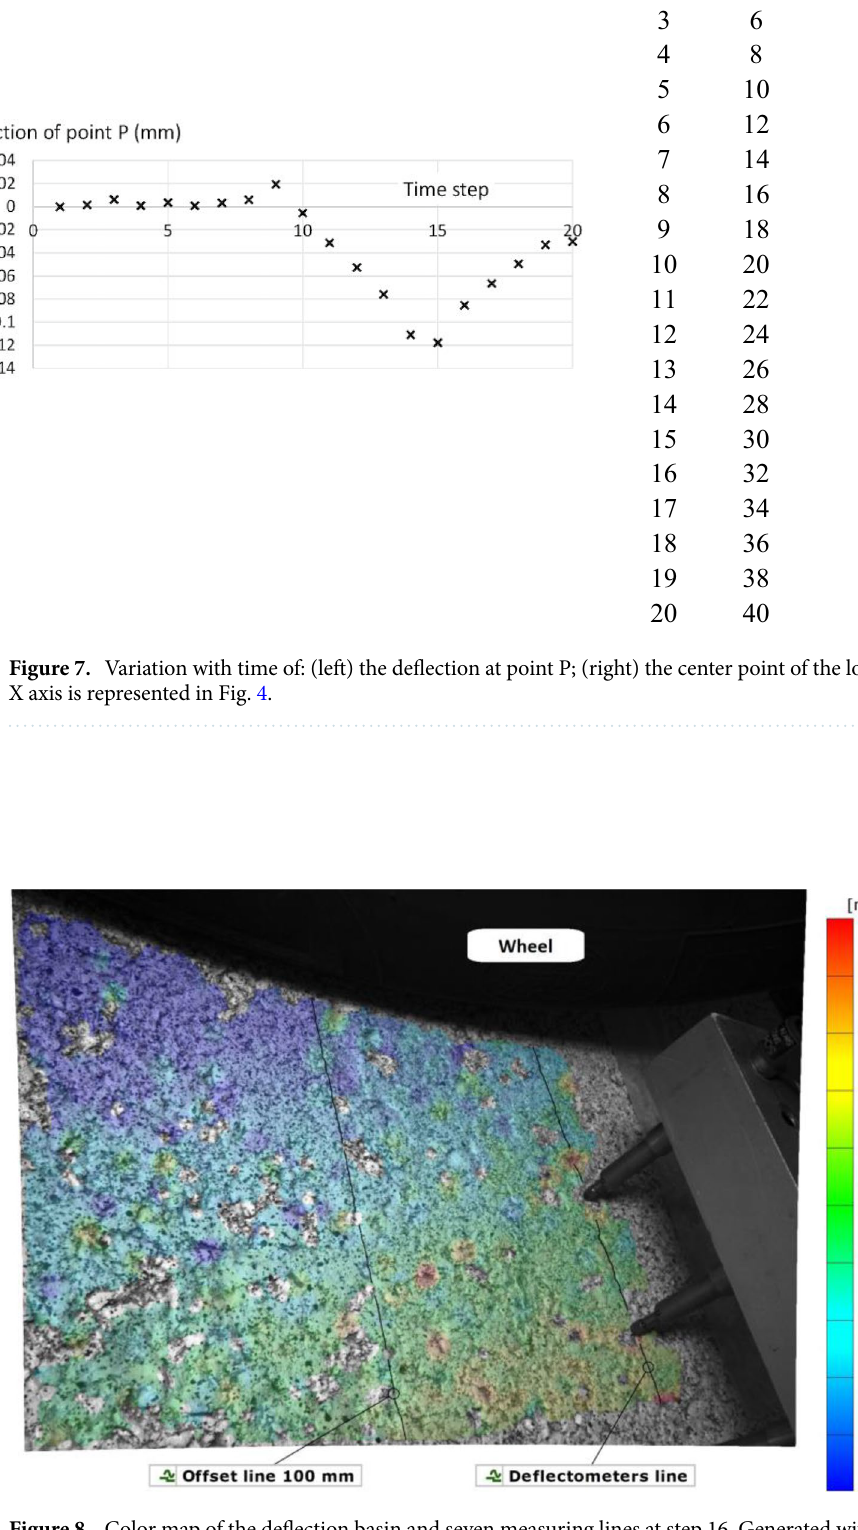
Figure 8. Color map of the deflection basin and seven measuring lines at step 16. Generated with GOM Inspect Pro (Aramis 3D v2019, GOM GmbH, Braunschweig,